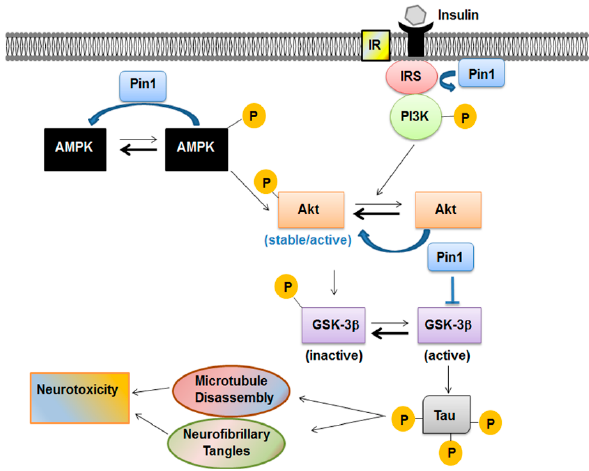
Figure 3. Pin1 in the metabolic pathway acts as a negative regulator of AMPK and modulates the Akt active form. Insulin promotes neuronal cytoskeletal dynamics via Akt phosphorylation. Activation of insulin signaling leads usually to activation of phosphatidyl-inositol-3-kinase/Akt (PI3K/Akt)